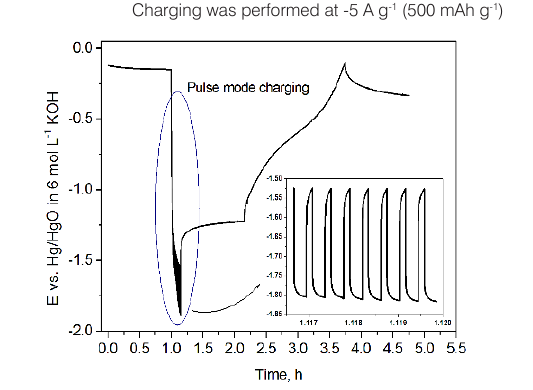
Figure 5. The hydrogen sorption/desorption (potential limit –0.1 V vs. Hg/HgO) (charging - 5A g -1 , i.e ., 500 mAh g -1 with a pulse mode, 1h rest and discharging at +200 mA g -1 )